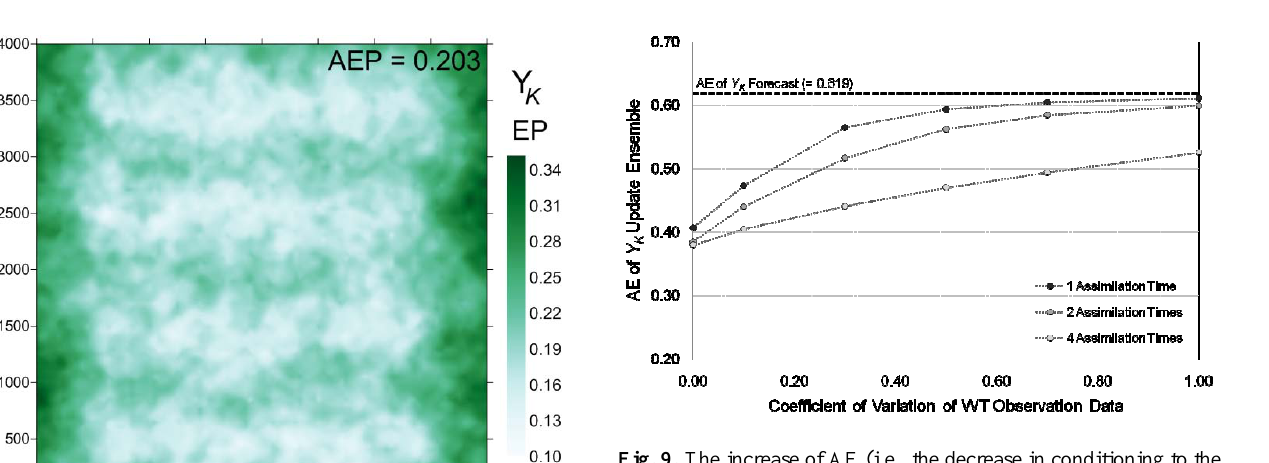
mean of the updated Y K ensemble using Y Q data from four gaging stations day period, with the CV of observation data set to